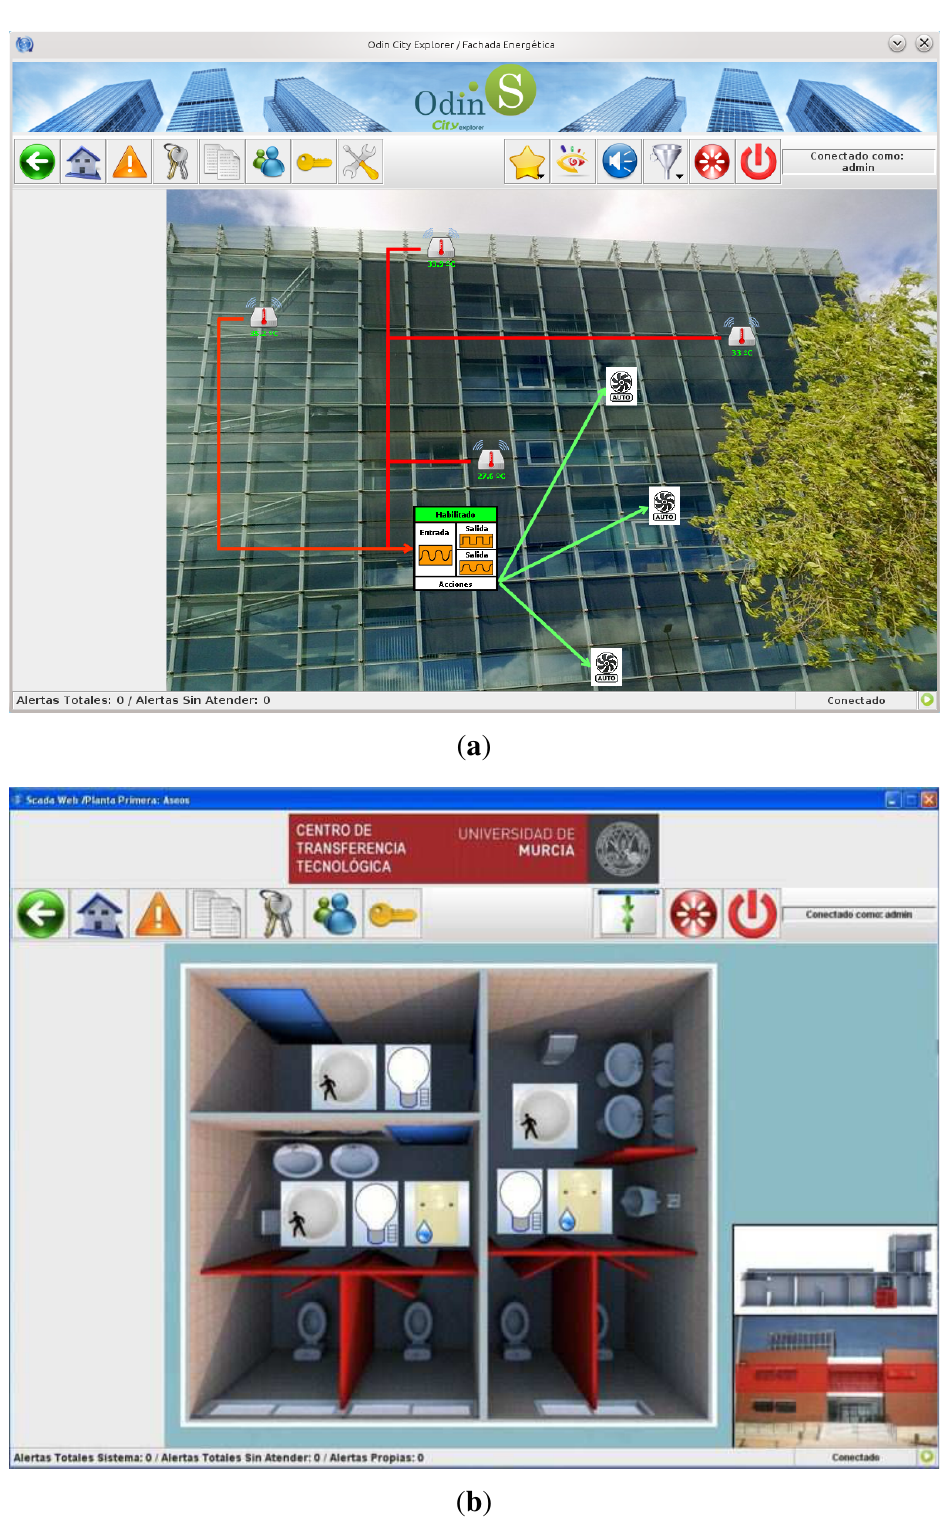
Figure 9. JNLP application with 3D HMI for local/remote management through